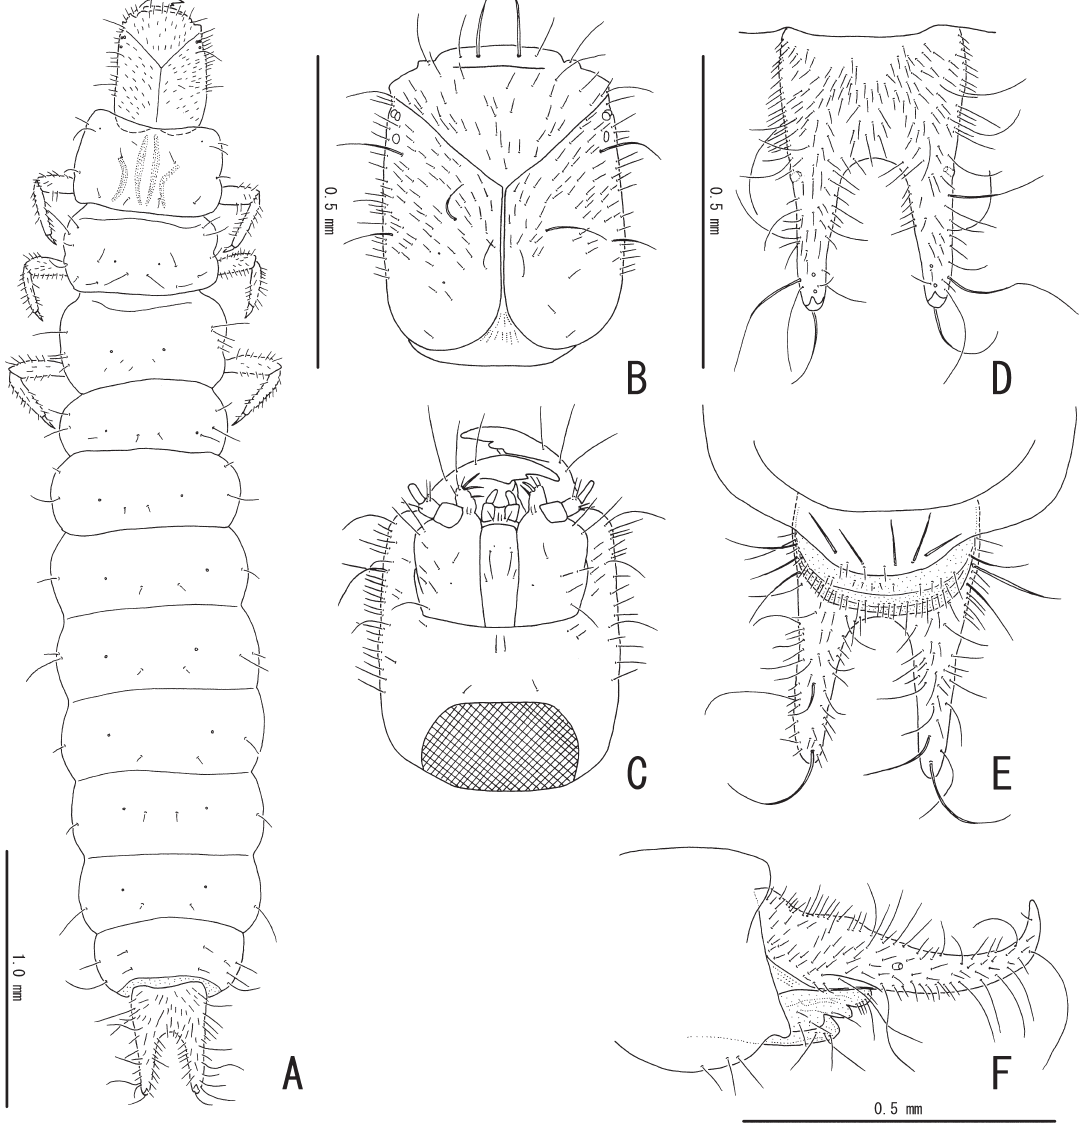
Fig. 10. Larva of Laius rodriguesensis sp. nov. A . Dorsal habitus. B . Head in dorsal view. C . Head in ventral view. D . Abdominal segment IX in dorsal view. E . Abdominal segment IX in ventral view. F . Abdominal segment IX in lateral